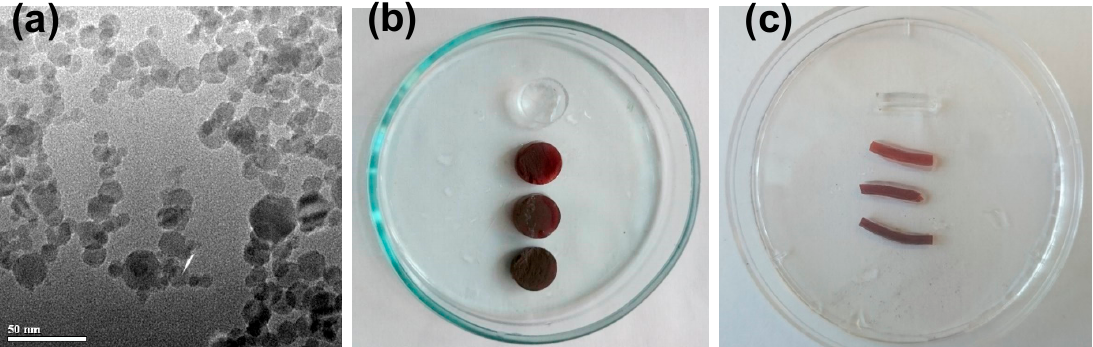
Figure 1. Transmission electron microscopy (TEM) image of laser target evaporation (LTE) iron oxide magnetic nanoparticles (MNPs) used for ferrogel synthesis ( a ). General view of gel and ferrogel samples from batch #1 ( b ) and batch #2 ( c ). See explanation in the text.